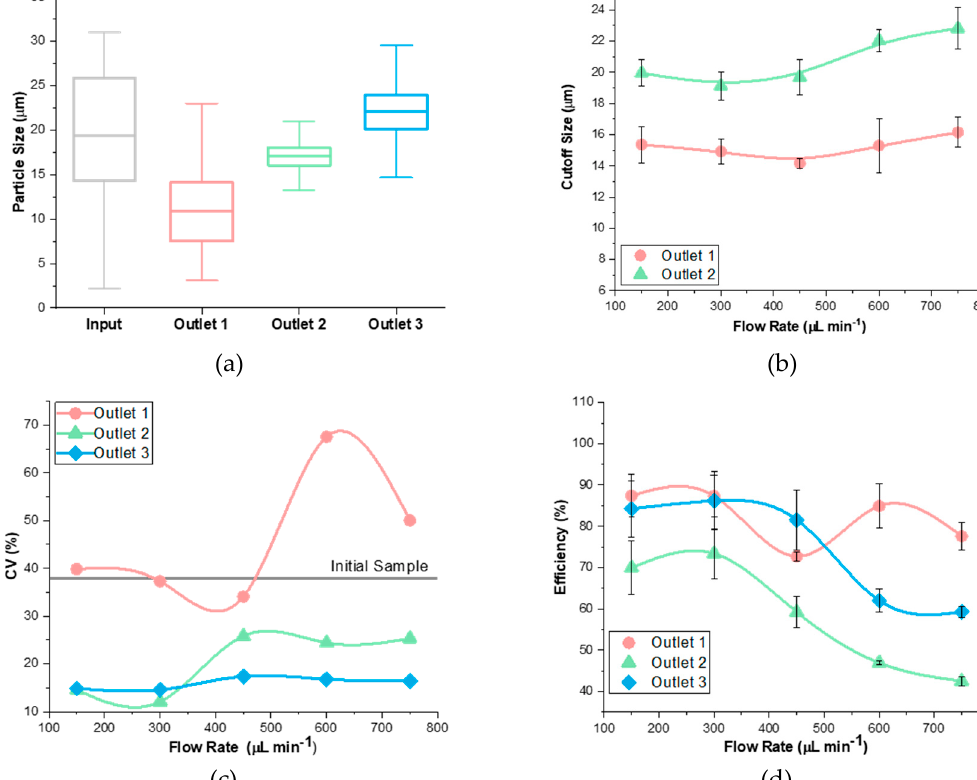
Figure 3. Sample flow rate impacts separation performance. ( a ) Fractionation of input sample into 3 outlets (300 μ L·min − 1 , 1:2 ratio, 0.59 resistance ratio). The whiskers on the box plots show the full range of particle sizes. ( b ) Cutoff size stays constant in outlet 1 but increases in outlet 2 with flow rate. ( c ) Coefficient of variance is low at a low flow rate but increases with flow rate. ( d ) Efficiency of separation is high at a low flow rate but decreases rapidly beyond 300 μ L·min − 1 .